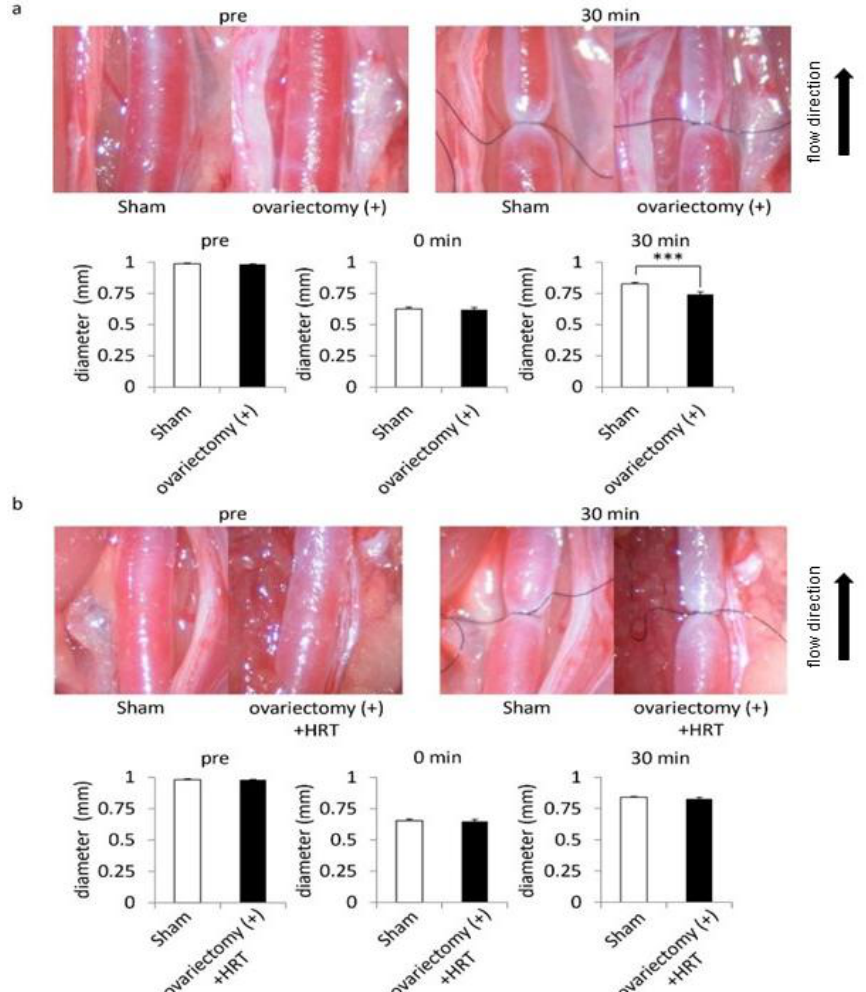
Figure 3. The disturbance of post-stenotic dilatation by the bilateral ovariectomy in female rats. 10-week-old female Sprague−Dawley rats were subjected to the bilateral ovariectomy or a sham-operation. On the 7th day, animals underwent the carotid ligation and the post-stenotic dilatation was observed for following 30 min ( a ). In some animals, hormone replacement therapy (HRT) was applied after the bilateral ovariectomy ( b ). Representative macroscopic images of the carotid artery before (pre) and 30 min after the ligation (30 min) are shown. The diameter of the carotid artery was calculated before (pre), just after (0 min) and 30 min after the ligation (30 min). Bars indicate the mean ± SEM ( n = 4). Statistical analysis was done by a Welch’s t test. ***; p < 0.001.